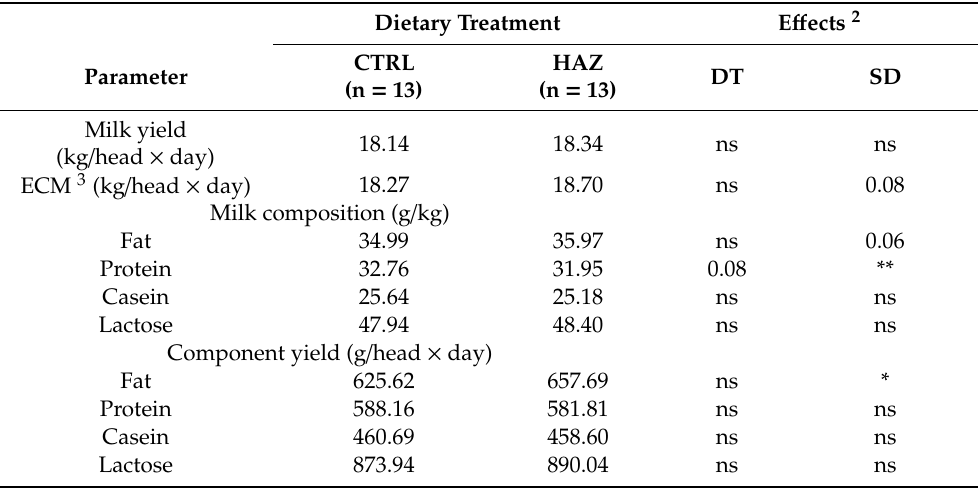
Table 3. Milk yield and milk main constituents of cows fed the control (CTRL) and hazelnut skin (HAZ) diets 1 .